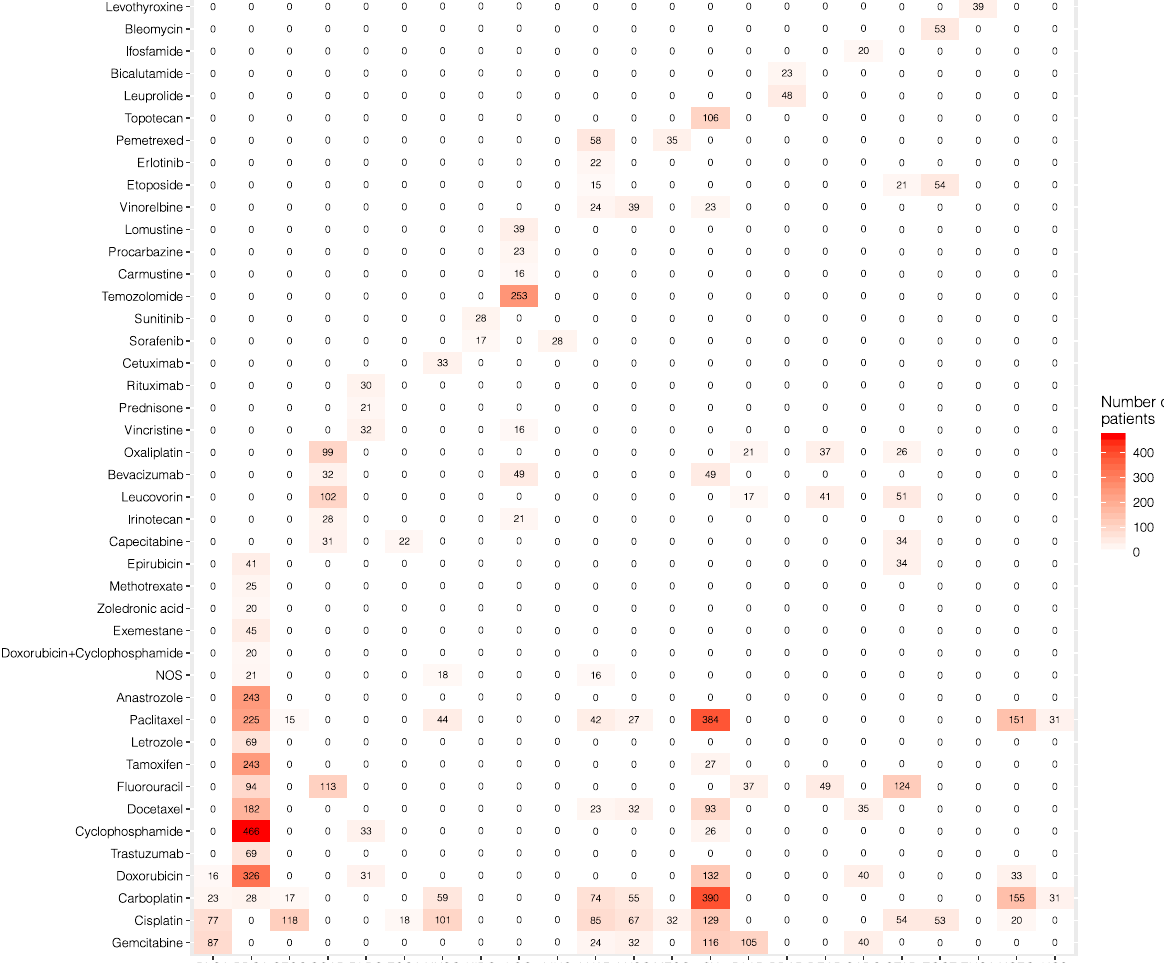
Figure 1. Heatmap of number of patients in each cancer-drug